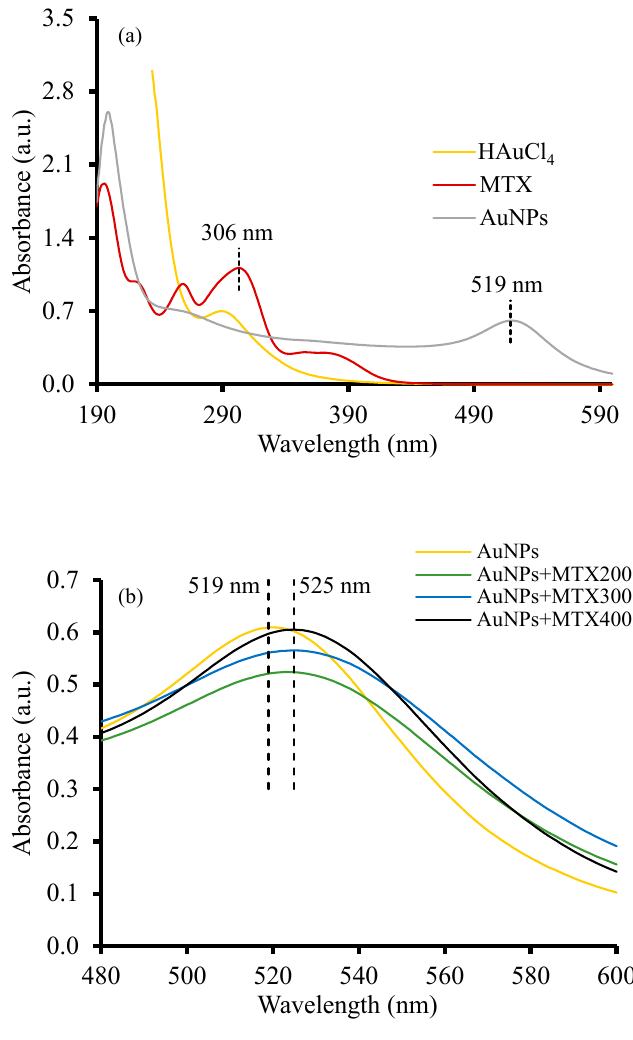
Figure 1. ( a ) Comparative UV-Vis absorption spectra of free MTX, HAuCl 4 and AuNPs. ( b ) Absorption spectra of AuNP–MTX conjugates with different concentrations of MTX.